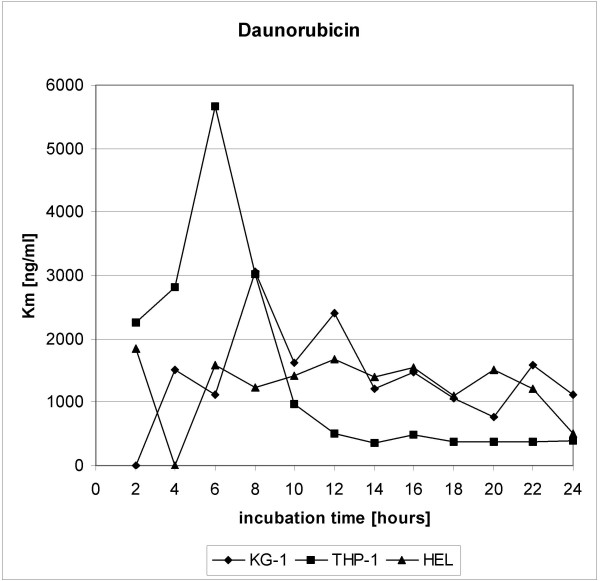
Average Km-values of daunorubicin and incubation time in the cell lines HEL, THP-1 and KG-1.